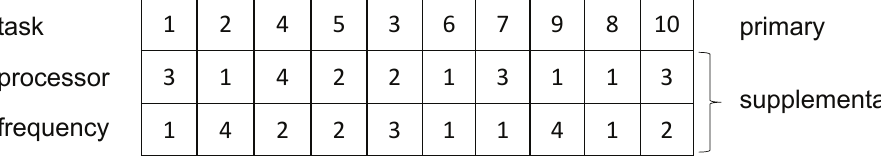
Figure 4. Encoding of a